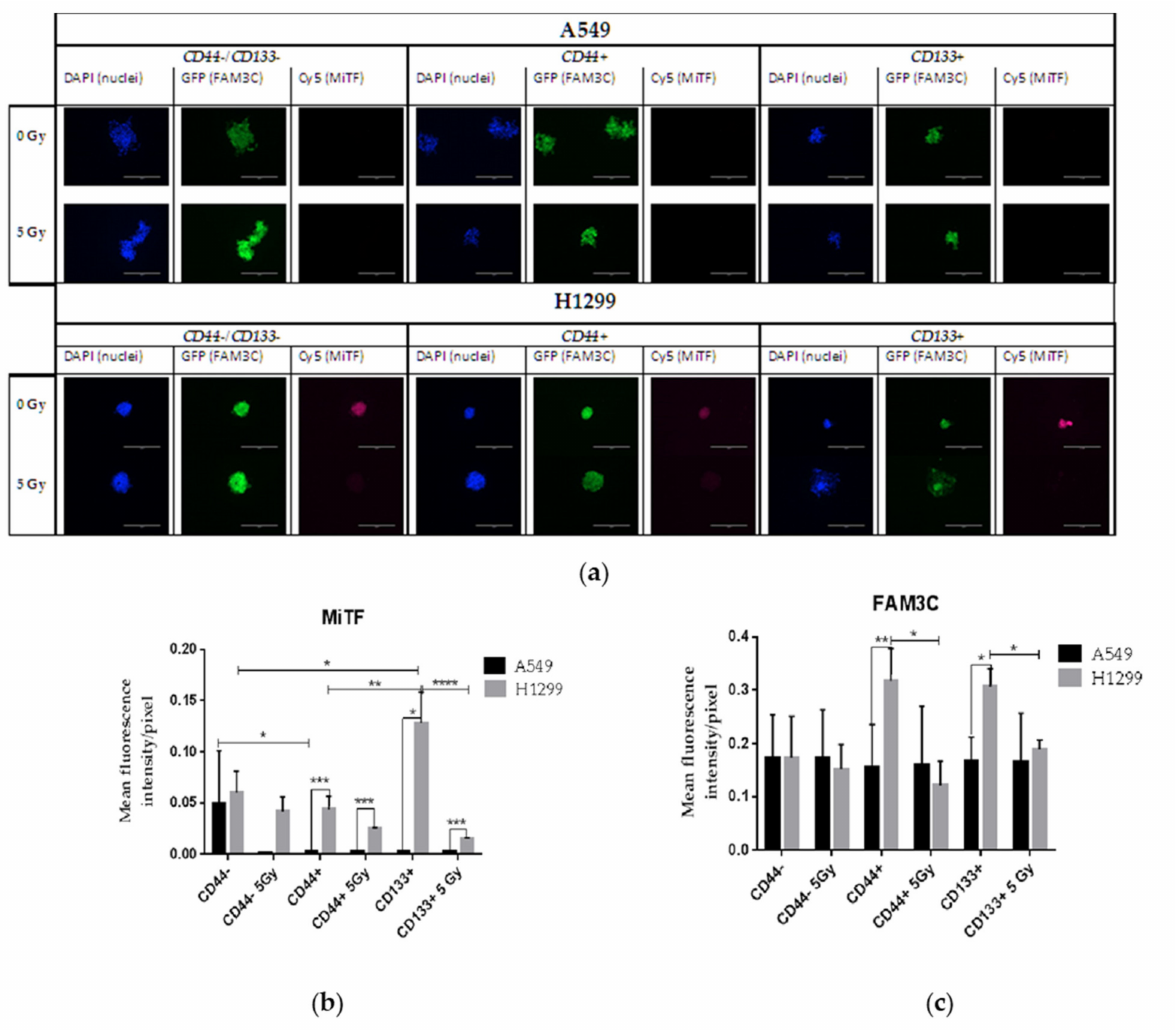
Figure 10. Representative microphotographs of immunofluorescently stained spheroids showing DAPI (blue), FAM3C (GFP, green) and MiTF (Cy5, pink) ( a ). The expression of MITF ( b ) and FAM3C ( c ) in spheroid cultures derived from CD-sorted populations of A549 and H1299 cell lines four days after 5 Gy irradiation. Data are means ± SEM of more than three independent experiments. Where: * p < 0.05, ** p < 0.01, *** p < 0.001, **** p <